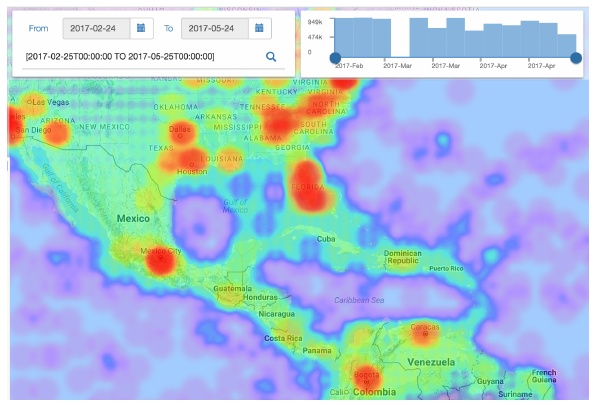
Figure 2. Using temporal faceting to provide temporal